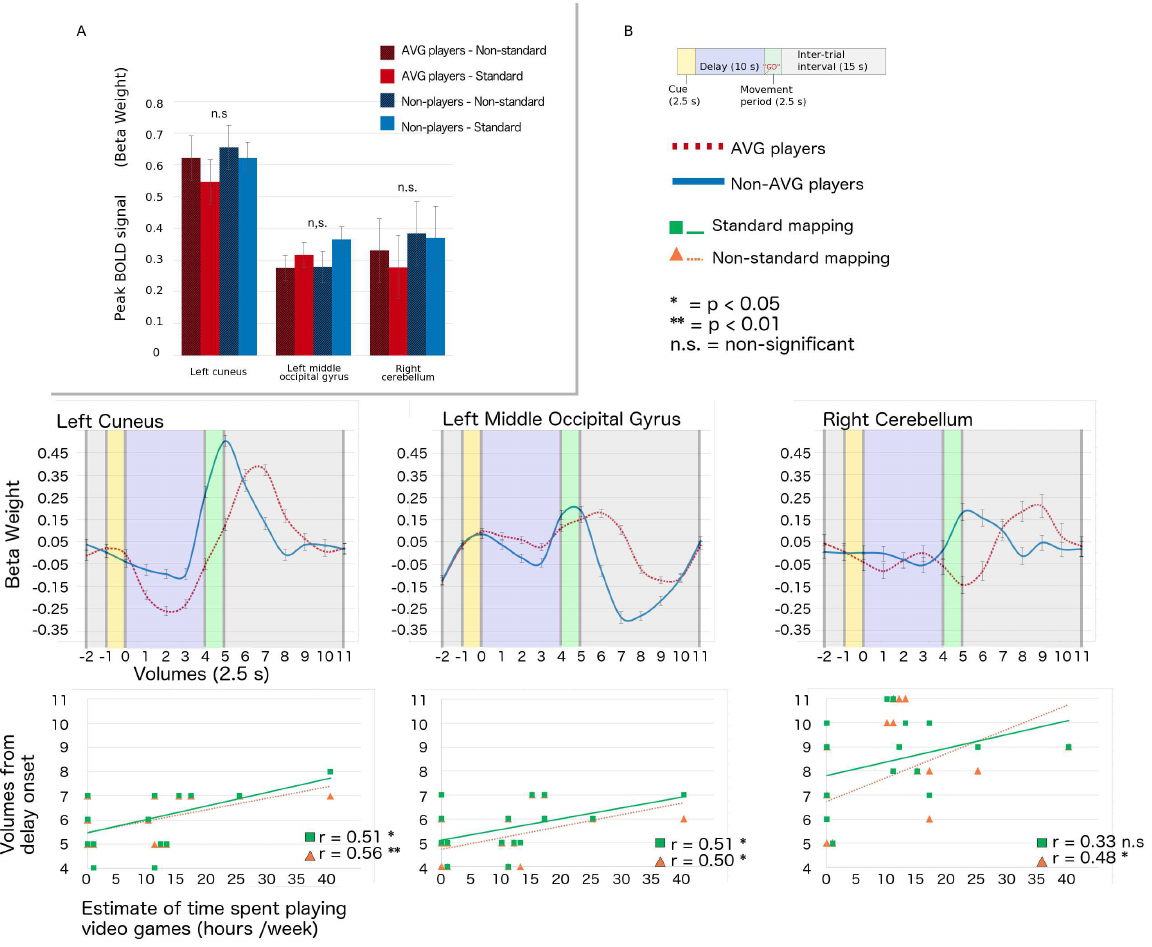
Fig 4. Relationship between the timing of peak BOLD response and time spent playing. A) Histogram of peak beta weights of trials of the standard and non-standard visuomotor mapping tasks for action video game (AVG) players (burgundy) and non-players (blue) for the full trial time course. Only regions of interest in which AVG players had significantly lower amplitude BOLD signal than non-players in the instructed- delay epoch of trials are shown. Error bars represent standard deviation. No statistically significant differences in peak signal amplitude were observed between experimental groups or visuomotor tasks. B) Top plots: Event-related averages of fMRI activity over trials time-locked to the onset of the delay period. Time-courses associated with the standard and non-standard mapping tasks have been pooled for visual clarity. Error bars represent standard deviation. Time-courses for AVG players shown with burgundy dashed lines and non-players shown with blue solid lines. Bottom plots: Linear regression results showing relationships between the timing of peak BOLD signal and estimates of time spent playing AVGs. Results for the standard mapping task shown with green squares and solid lines. Results for the non-standard mapping task shown with orange triangles and dashed lines. See Table 3 for specific p -values.